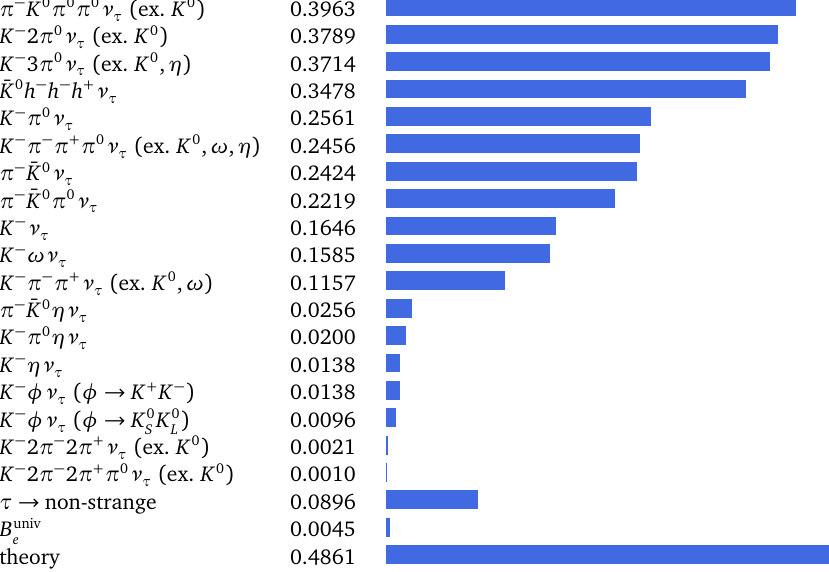
Table 2: Contributions to the | V